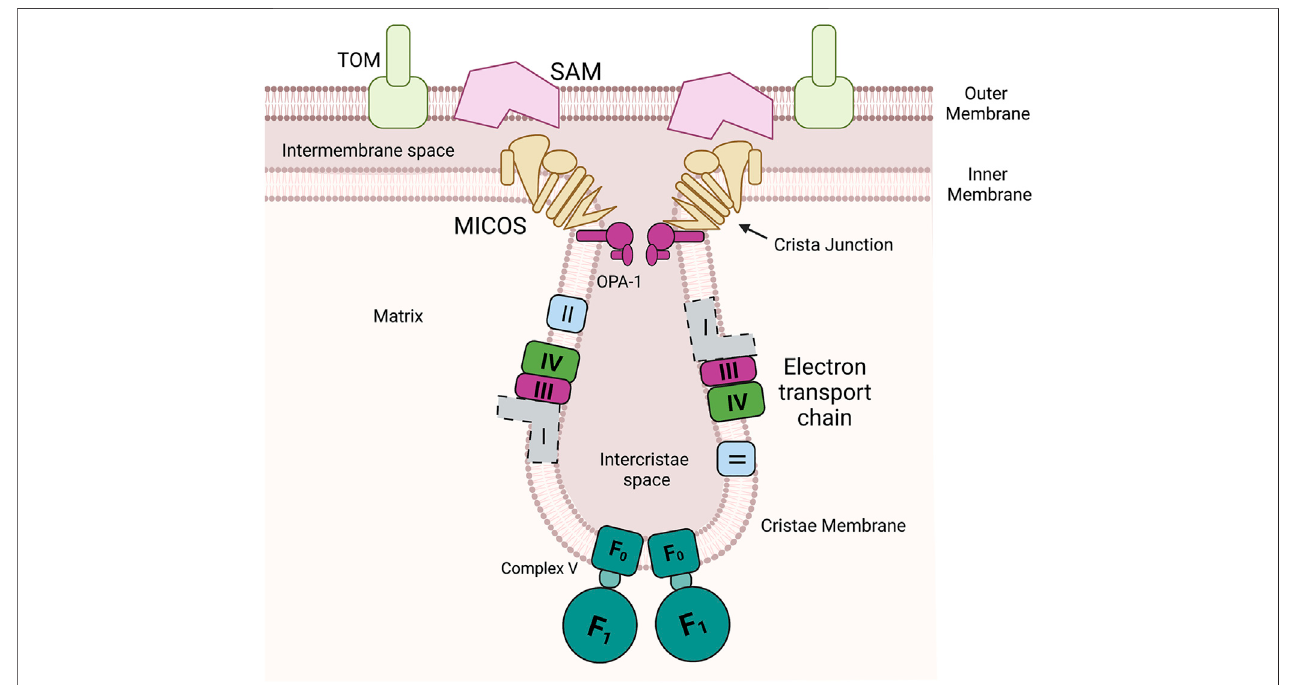
FIGURE 1 | Mitochondria have multiple unique compartments. Outer membrane is a porous membrane that allows exchange of metabolites and small molecules with the cytosol but restricts the entry of proteins to the intermembrane space. The inner membrane is a highly protein loaded membrane that folds into invaginations known ascristae. The cristae house the assembled components ofthe oxidativephosphorylation (Complex I, II, III, and IV and ATPsynthase (F 0 F 1 ATPase, ComplexV). In mammals this includes a membrane spanning NADH oxidoreductase (Complex I) (shown with dotted lines due differences between yeast and mammals), in yeast this enzyme is soluble in the matrix. The mitochondrial contact site and cristae organizing system (MICOS) and Opa-1 cooperate to form cristae junctions that encloses the intercristae space. MICOS also provides a structural point of contact between the inner and outer membrane via an interaction with the sorting and assembly machinery